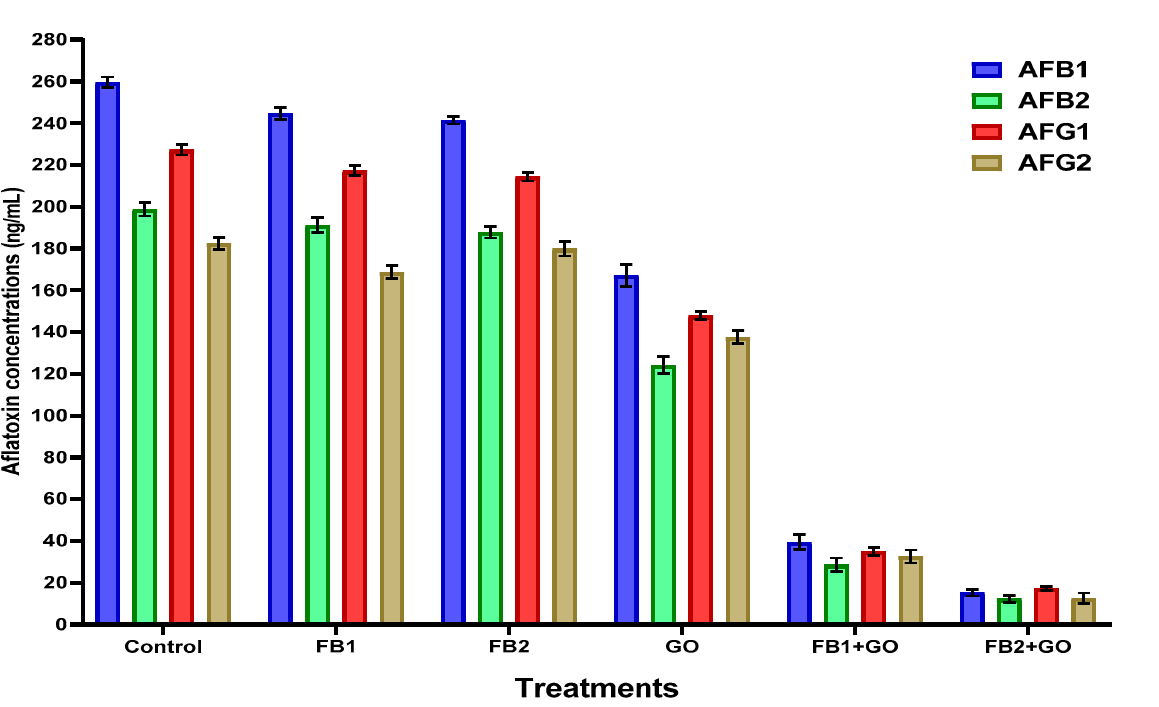
Figure 1. The applied composites (FB1, FB2, and GO-loaded emulsions) affected the aflatoxin pro- duction in the simulated liquid media. The results were represented as mean ± SEM (standard error means; n = 3). The results were expressed as aflatoxin reduction measured in nanogram/milliliter (ng/mL). FB1—coated emulsion composite consisted of maltodextrin, CMC, Arabic gum, and Guar gum. FB2:—coated emulsion composite consisting of sodium alginate, whey protein, and ginger oil. GO—ginger